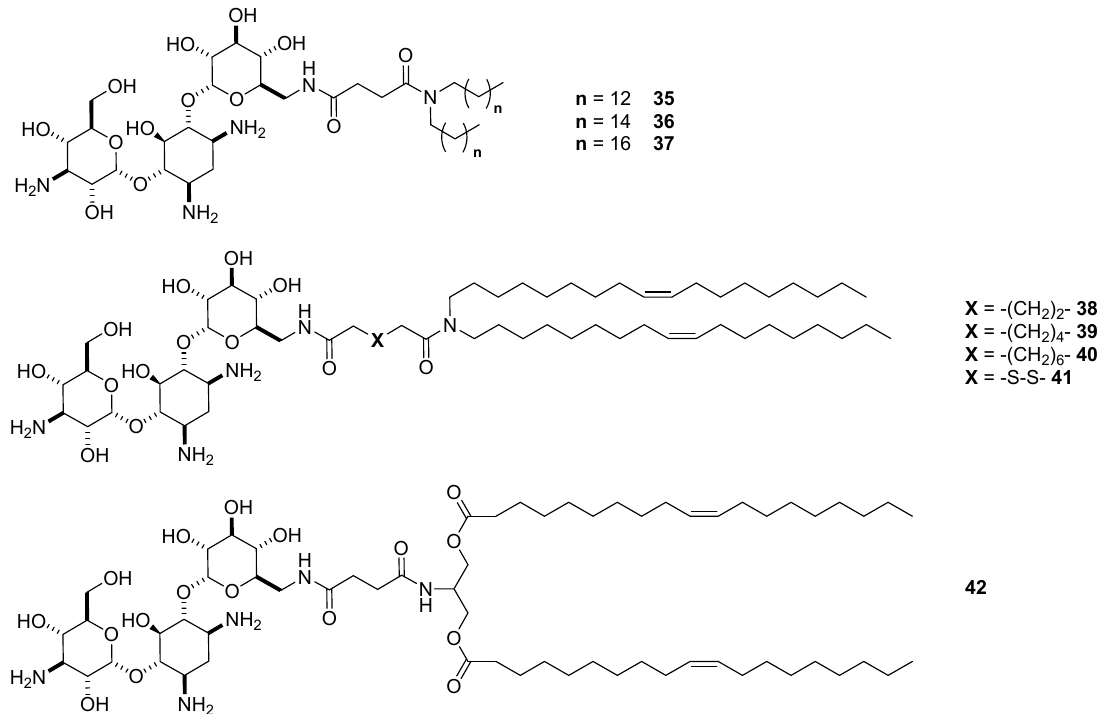
Figure 11. Tobramycin-based lipids 35 – 42 tested as mRNA, DNA, and siRNA delivery vectors .